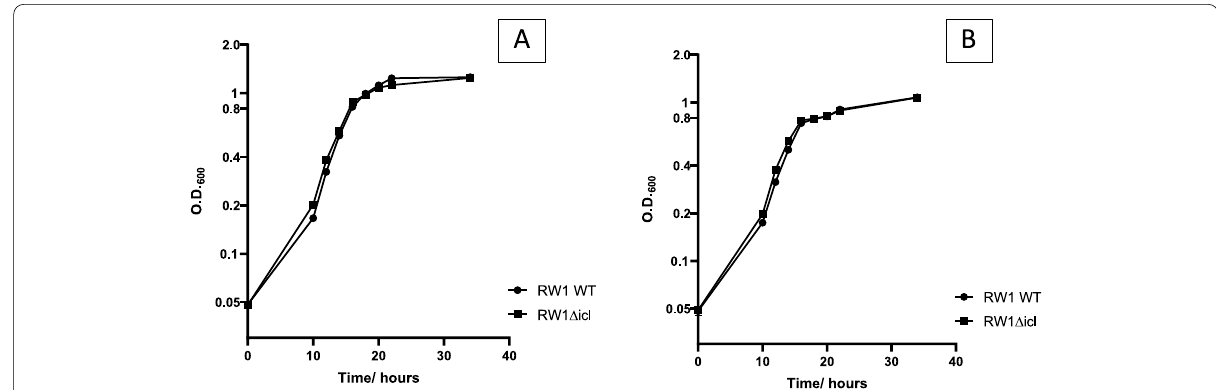
Fig. 3 Effect of icl deletion on growth of S. wittichii RW1 on DBF ( A ) and DD ( B ). DBF (3 mM) and DD (3 mM) were added as crystals in MSB medium as a sole carbon